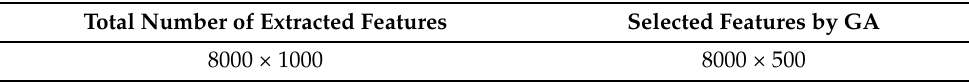
Table 2. Feature selection overview for the proposed model. Total Number of Extracted Features Selected Features by GA